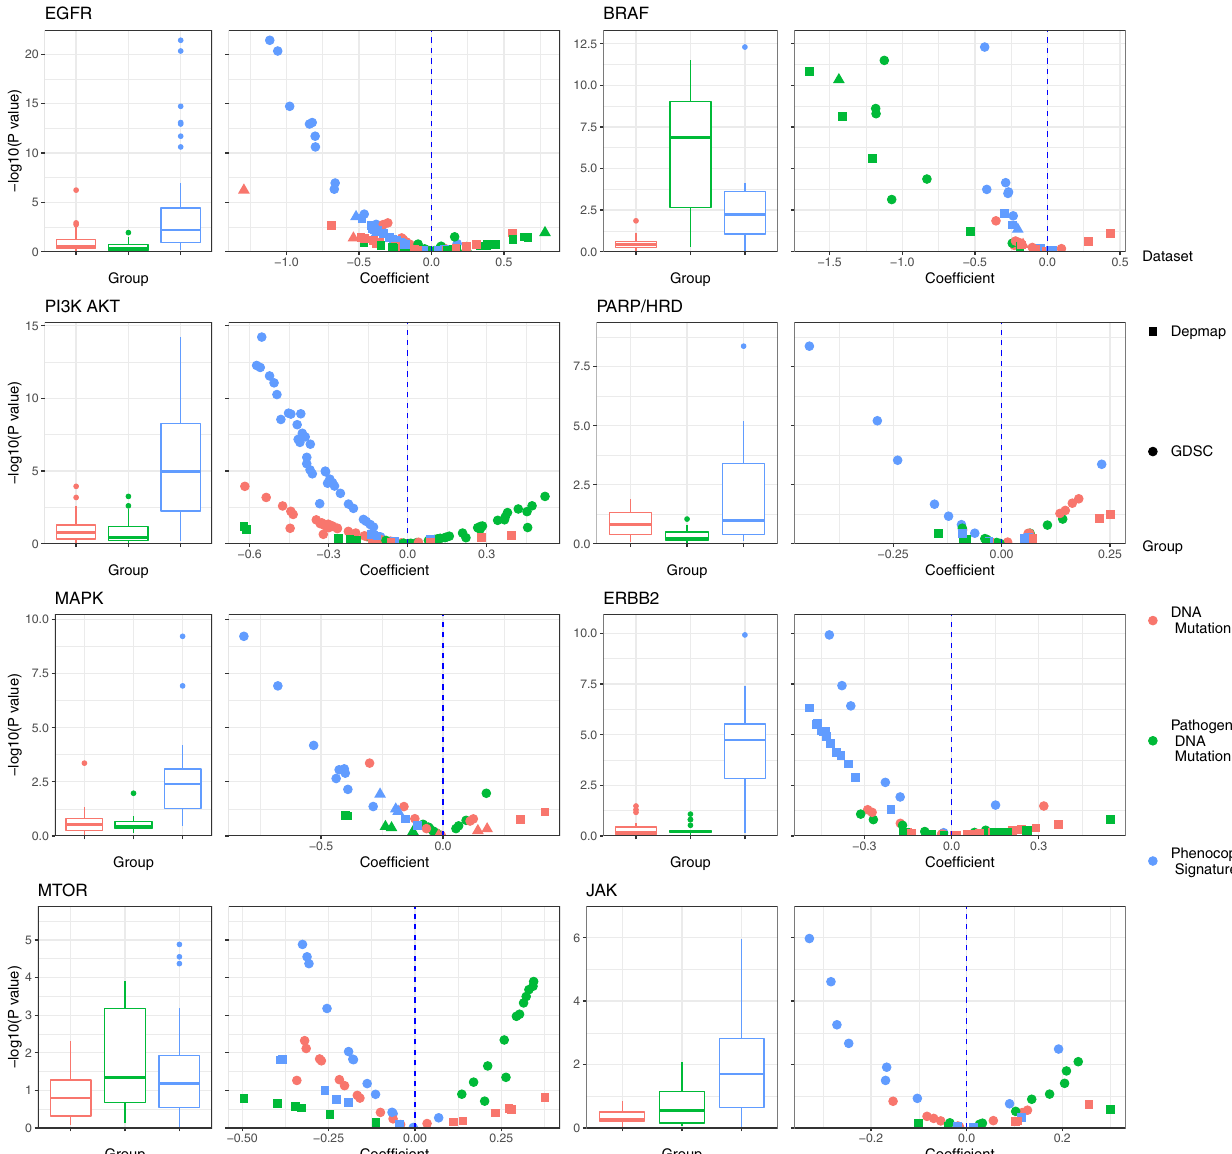
Fig. 3 Detailed comparison of phenocopy signatures to DNA mutations. Linear models for drug response were used to assess how much the phenocopy signatures added to DNA mutations across pathways. Each model of a single drug is represented by three points, one for each independent variable (DNA mutation, pathogenic mutation, and phenocopy signature). The x -axis represents the linear coef fi cient, and the y -axis is the associated -Log 10 ( p -value) of each independent variable in each linear model. Pathogenic mutations are mutations which are annotated as pathogenic by ClinVar or computational tools. Negative coef fi cients represent expected estimates, where the actual mutation status or predicted mutation status from the phenocopy signature is associated with increased sensitivity to the drug. Data points in the upper-left quadrant therefore represent drugs for which the phenocopy signature most signi fi cantly contributed to predicting drug sensitivity. Boxplot center line = median value, bounds of box (hinges) = interquartile range (IQR), bounds of whiskers = maximum of 1.5X IQR from the